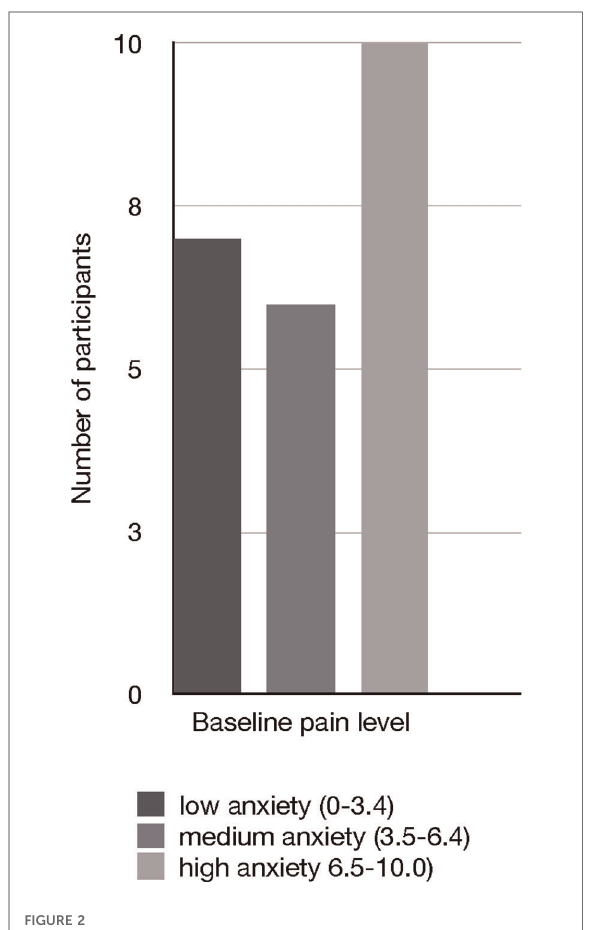
FIGURE 2 The fi gure depicts patients ’ pain levels as measured on a visual analog scale (1 – 100 mm) before the